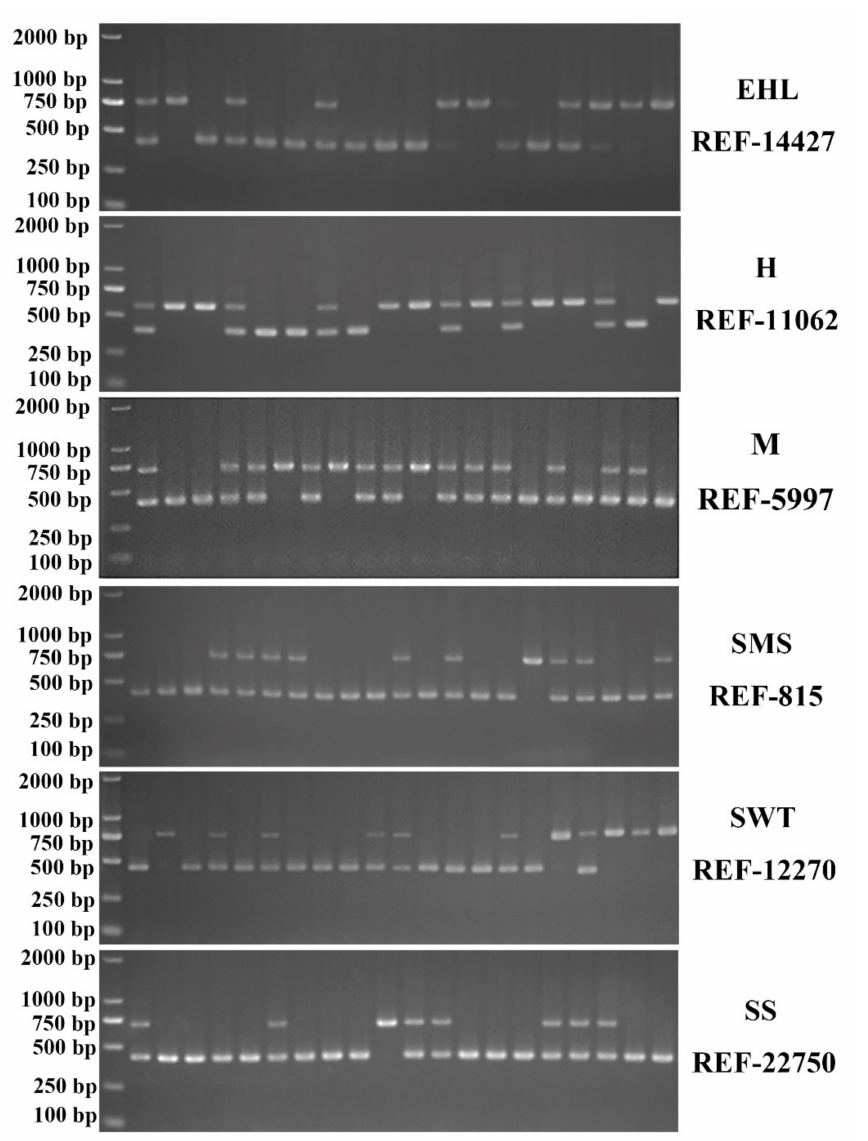
Figure 2. Representative electropherograms of SINE-RIPs detected in some pig breeds. EHL, Er- hualian; H, Huai; M, Mi; SMS, Small meishan; SWT, Shawutou; SS,